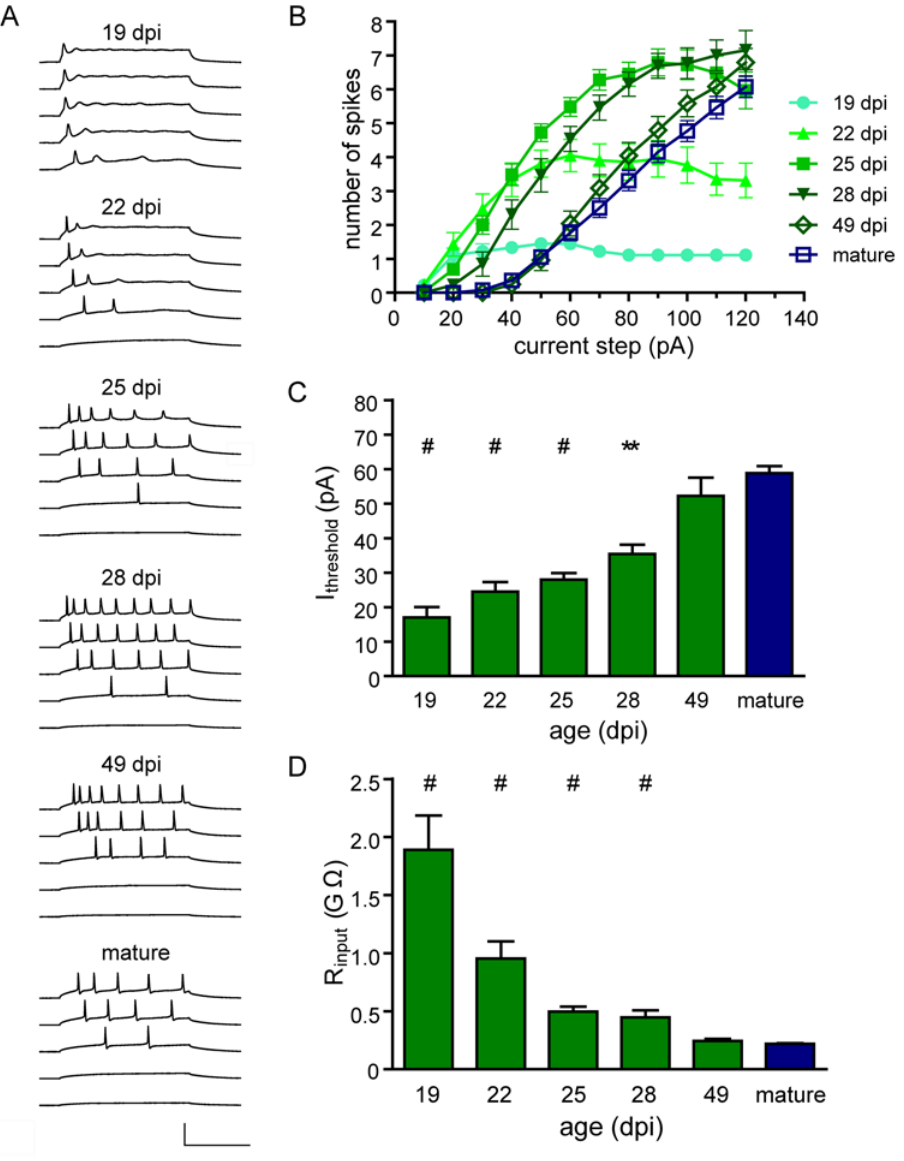
Figure 1. Young neurons are highly excitable. (A) Whole-cell current clamp recordings in neurons of different ages, as indicated on top of each panel. Spiking was elicited by depolarizing current steps of increasing amplitude (step=10 pA). Each panel shows a subset of five representative traces with steps 10, 30, 50, 70 and 90 pA (from bottom to top). Scale bars: 100 mV, 100 ms. (B) Repetitive firing quantified as the number of spikes elicited by increasing current steps. Sample sizes are N=10 (19 dpi), 20 (22 dpi), 29 (25 dpi), 13 (28 dpi), 24 (49 dpi) and 51 (mature). (C) Current threshold to elicit the first spike for the experiments shown in (B). ( # ) denotes p , 0.001, and (**) denotes p , 0.01 when compared to mature values. Statistical analysis was done by ANOVA followed by a Bonferroni’s test. (D) Input resistance as a function of age. ( # ) denotes p , 0.001 when compared to mature as analyzed by a Kruskal–Wallis test followed by a post hoc Dunn’s test, with N=13 (19 dpi), 23 (22 dpi), 23 (25 dpi), 18 (28 dpi), 18 (49 dpi) and 85